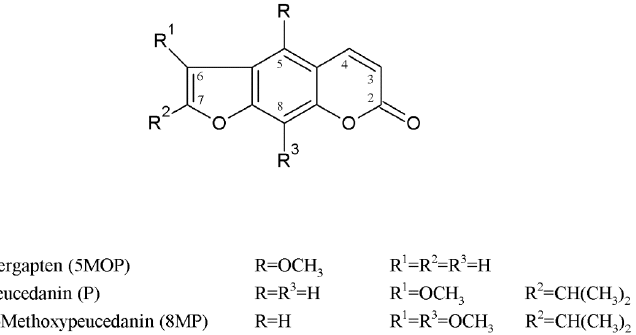
Figure 1. The chemical structure of methoxyfuranocoumarins isolated from P. tauricum fruits.